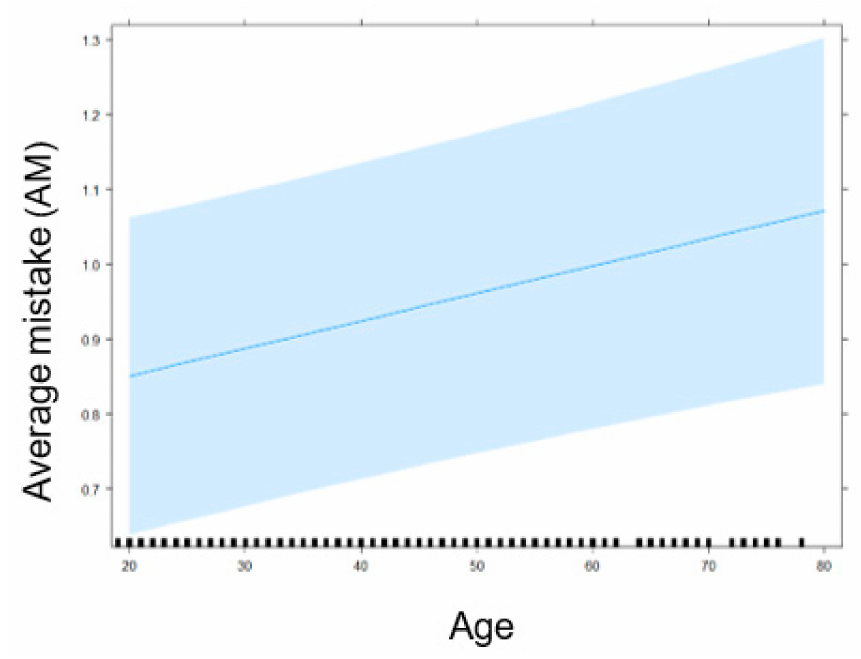
Figure 1. Impact of Age on AM in the healthfulness estimation